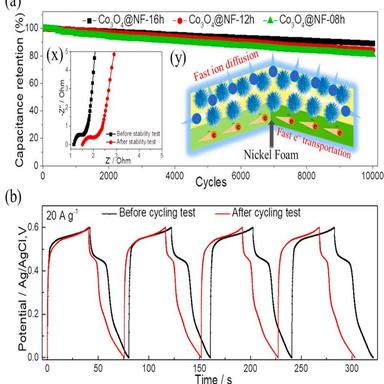
Cycling stability test of Co3O4@NF electrodes (inset (x) shows the EIS spectrum before and after cycling stability tests for Co3O4@NF-16h electrode and inset (y) shows the charge storage mechanism), (b) First and last four GCD curves for Co3O4@NF-16h electrode.